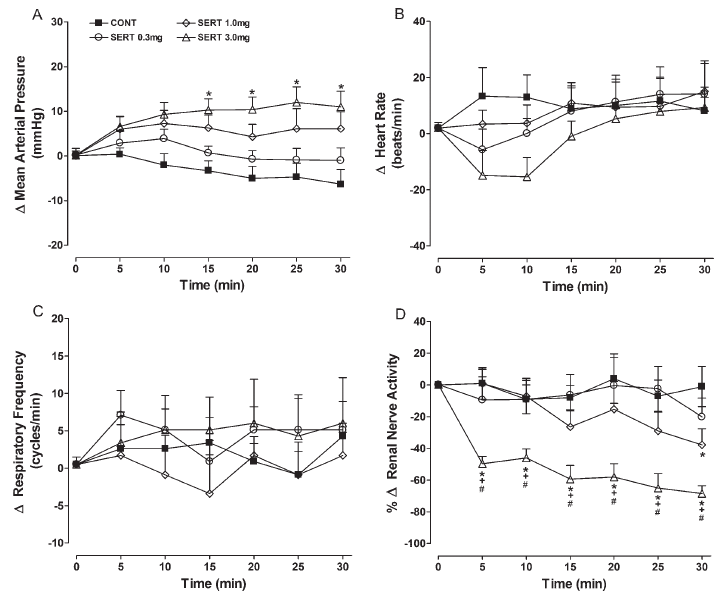
Figure 3. Effects of iv sertraline (0.3, 1, and 3 mg/kg) administration on mean changes ( D ) in A , mean arterial pressure; B , heart rate; C , respiratory frequency; D , renal nerve activity. Data are reported as means±SE for n=7 rats per group. CONT: control; SERT: sertraline (0.3, 1, or 3 mg/kg). *P , 0.05, SERT (0.3, 1, and 3 mg/kg) vs CONT; + P , 0.01, 3 mg/kg SERT vs 0.3 mg/kg SERT; # P , 0.01, 3 mg/kg SERT vs 1 mg/kg SERT (ANOVA followed by the Tukey